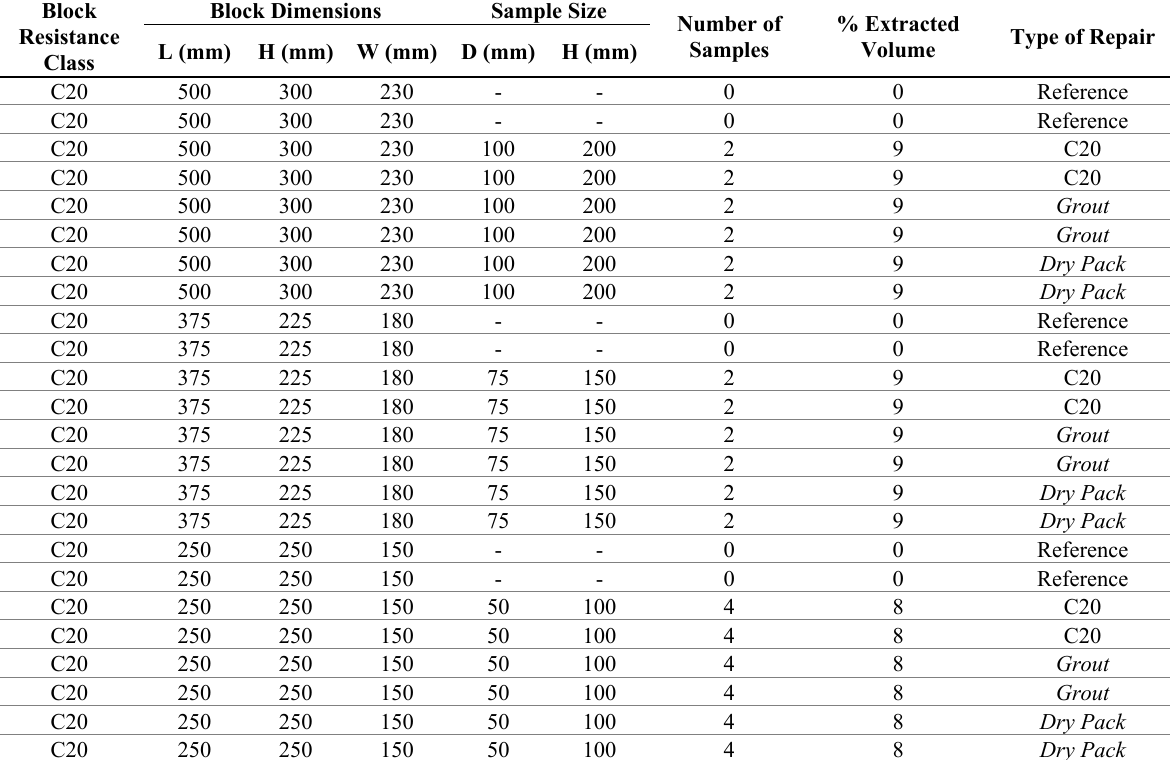
Table 1 – Concrete block and core sample